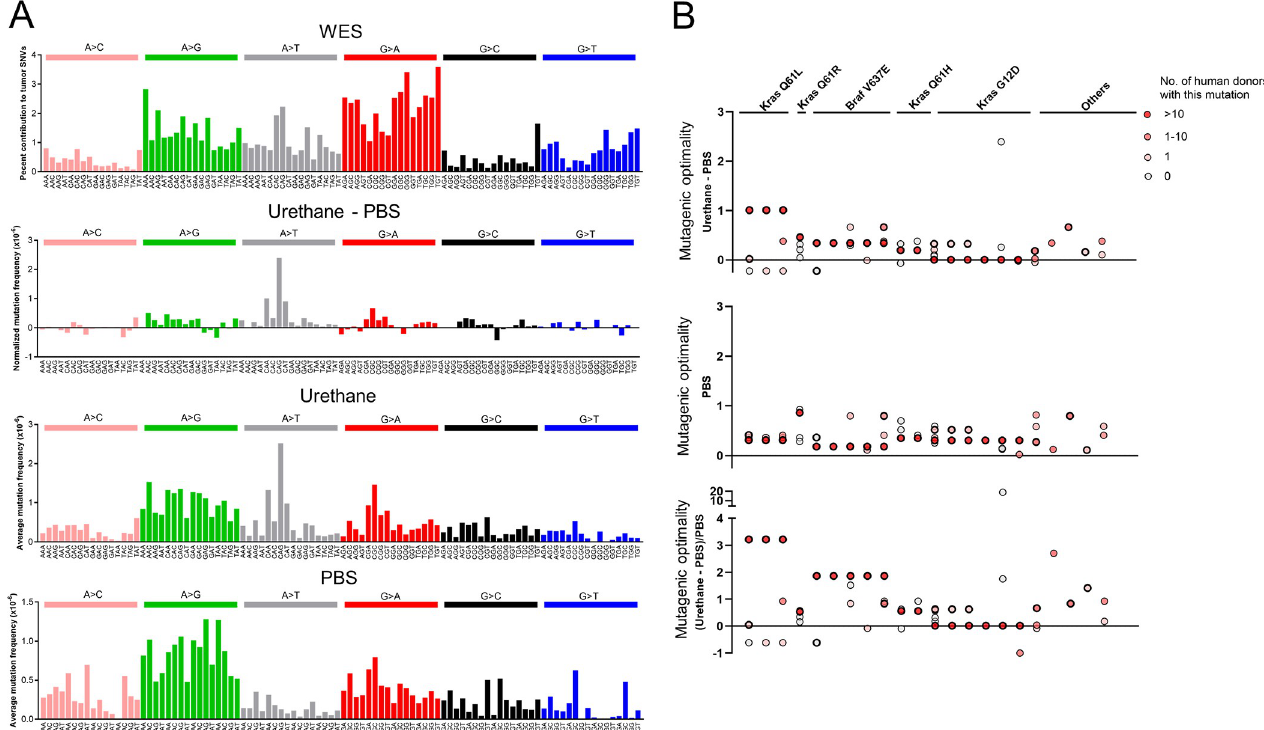
Fig 3. Multiple mutational processes contribute to putative genomic driver mutations. ( A ) Mutation spectrum measured by MDS for PBS, urethane, urethane normalized to PBS-treated mouse lung tissues and mutation spectrum measured by WES for urethane-induced mouse lung tumors. ( B ) Mutagenic optimality of putative genomic driver mutations identified by MDS for urethane normalized to PBS-treated and PBS-treated mouse lung tissues as well as the ratio of the former divided by the latter. Data are plotted for individual tumors and the genomic driver mutations occurring in more than 10 human cancer patients are indicated at the top. Others refers to tumors without a genomic driver mutation identified. Thick circles denote mutants validated by Sanger sequencing.